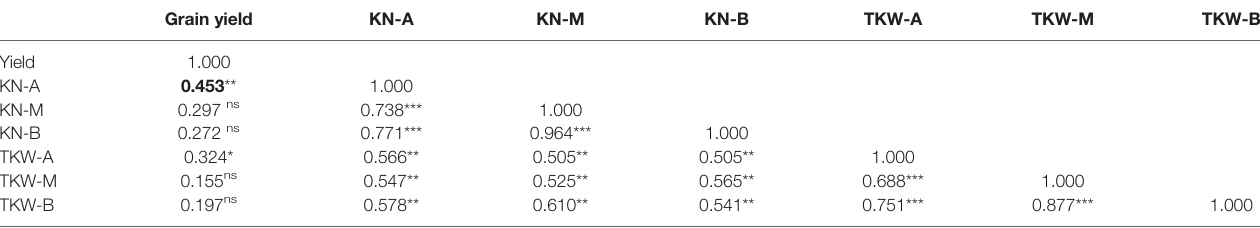
TABLE 2 | Relationships between yield and yield components in three sections of maize spikes based on Pearson ’ s correlation analysis. Grain yield